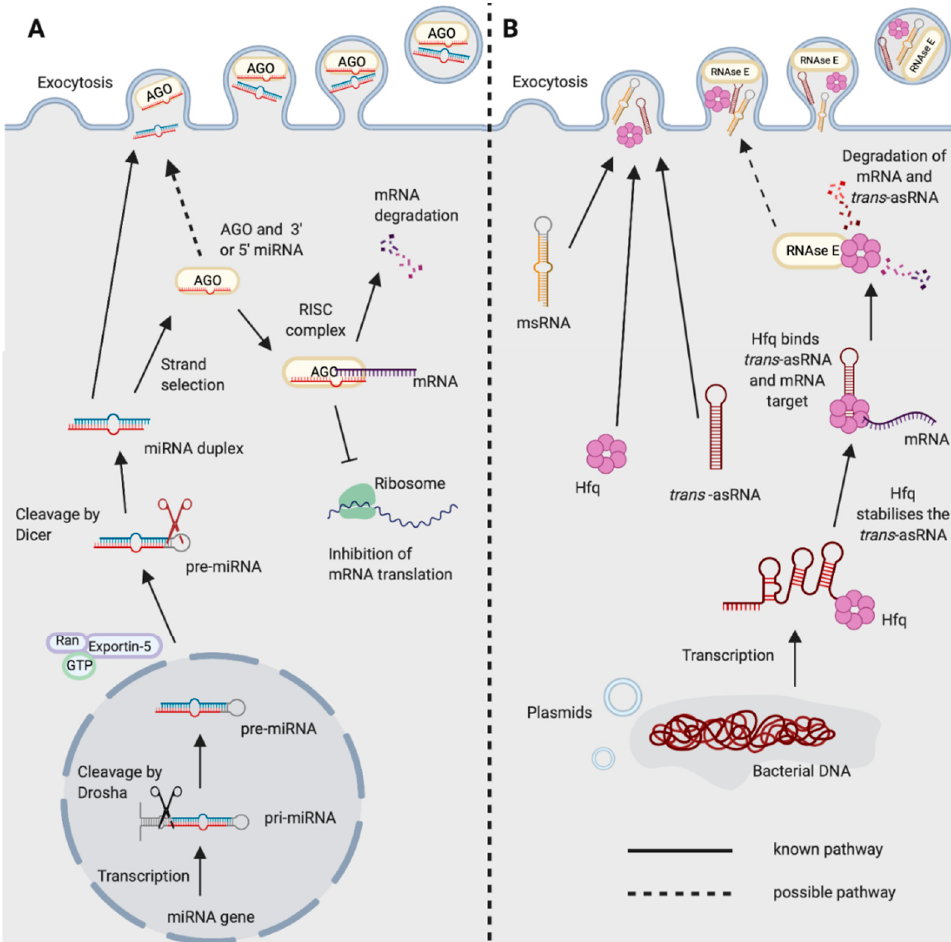
Figure 1. Biogenesis and functions of ( A ) miRNAs in eukaryotes and ( B ) trans -asRNAs in bacteria. ( A ) Eukaryotic miRNAs are transcribed in the nucleus into a pre-cursor primary-miRNA (pri-miRNA) transcript. The pri-miRNA is cleaved by Drosha (black scissors) to form a shorter hairpin, the pre-miRNA. The pre-miRNA is exported from the nucleus by exportin-5 in conjunction with ran-GTP.Inthecytoplasm, the pre-miRNA is cleaved further by Dicer (red scissors) to form a miRNA duplex. One strand from